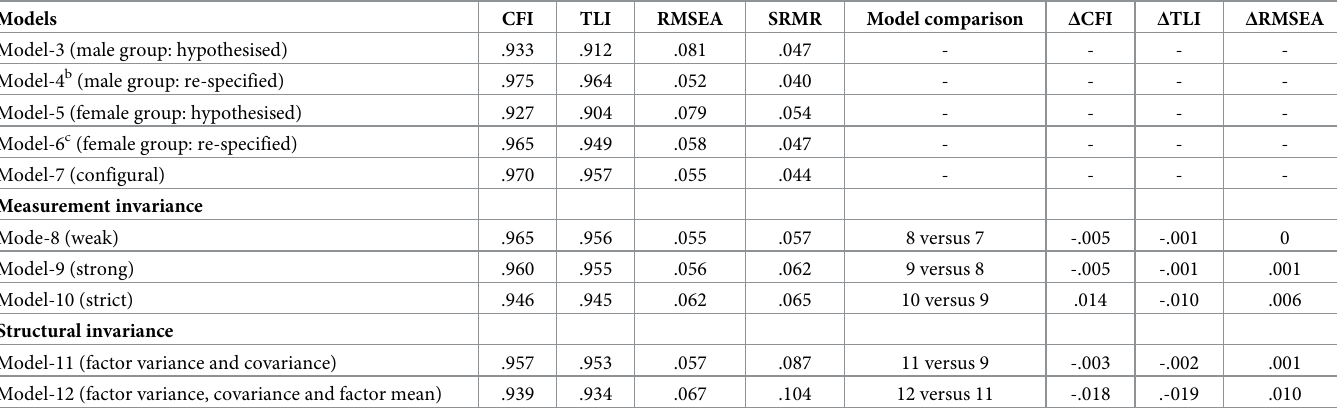
Table 3. The measurement model of DB-M baseline model fit results and tests of measurement and structure